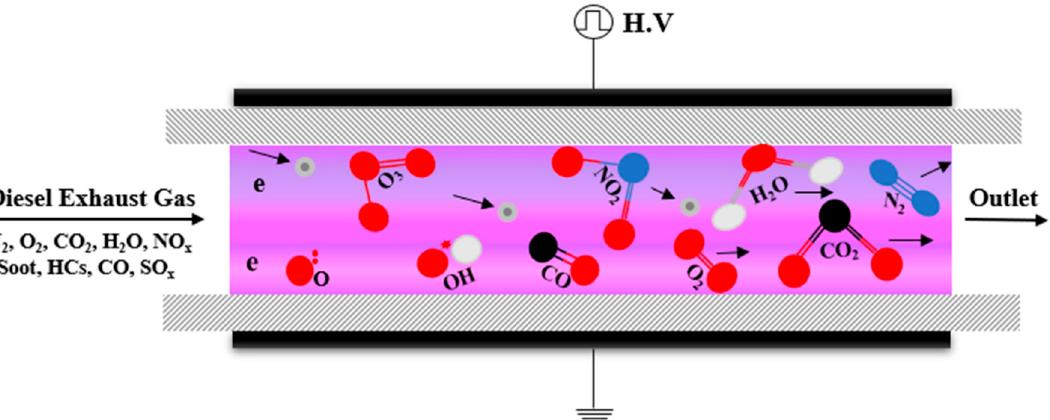
Figure 5. Most common configuration for plasma reactors in DEG treatment applications. The arrows show the trajectories of the ionized particles after collisions from the treatment gas inlet to the outlet. Reproduced from reference [76], published under the license CC BY 4.0.